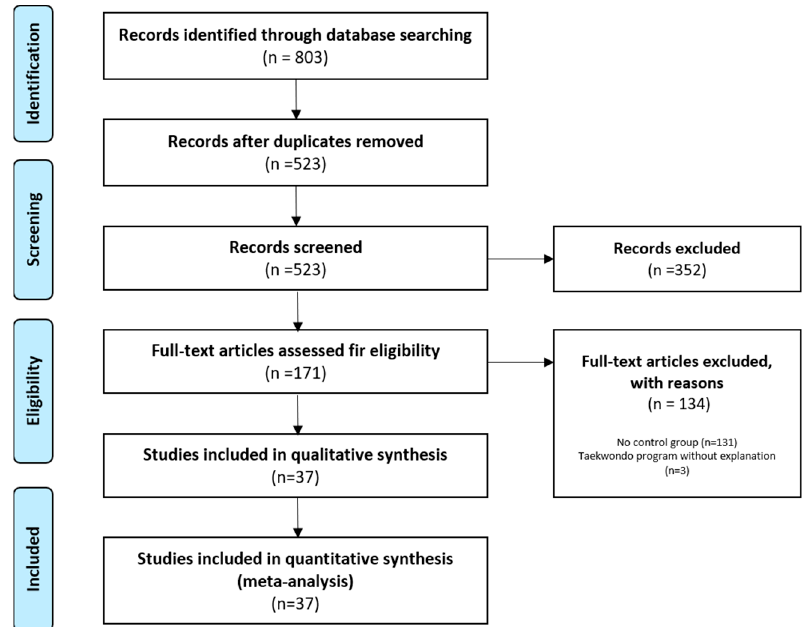
Figure 1. PRISMA flow diagram.